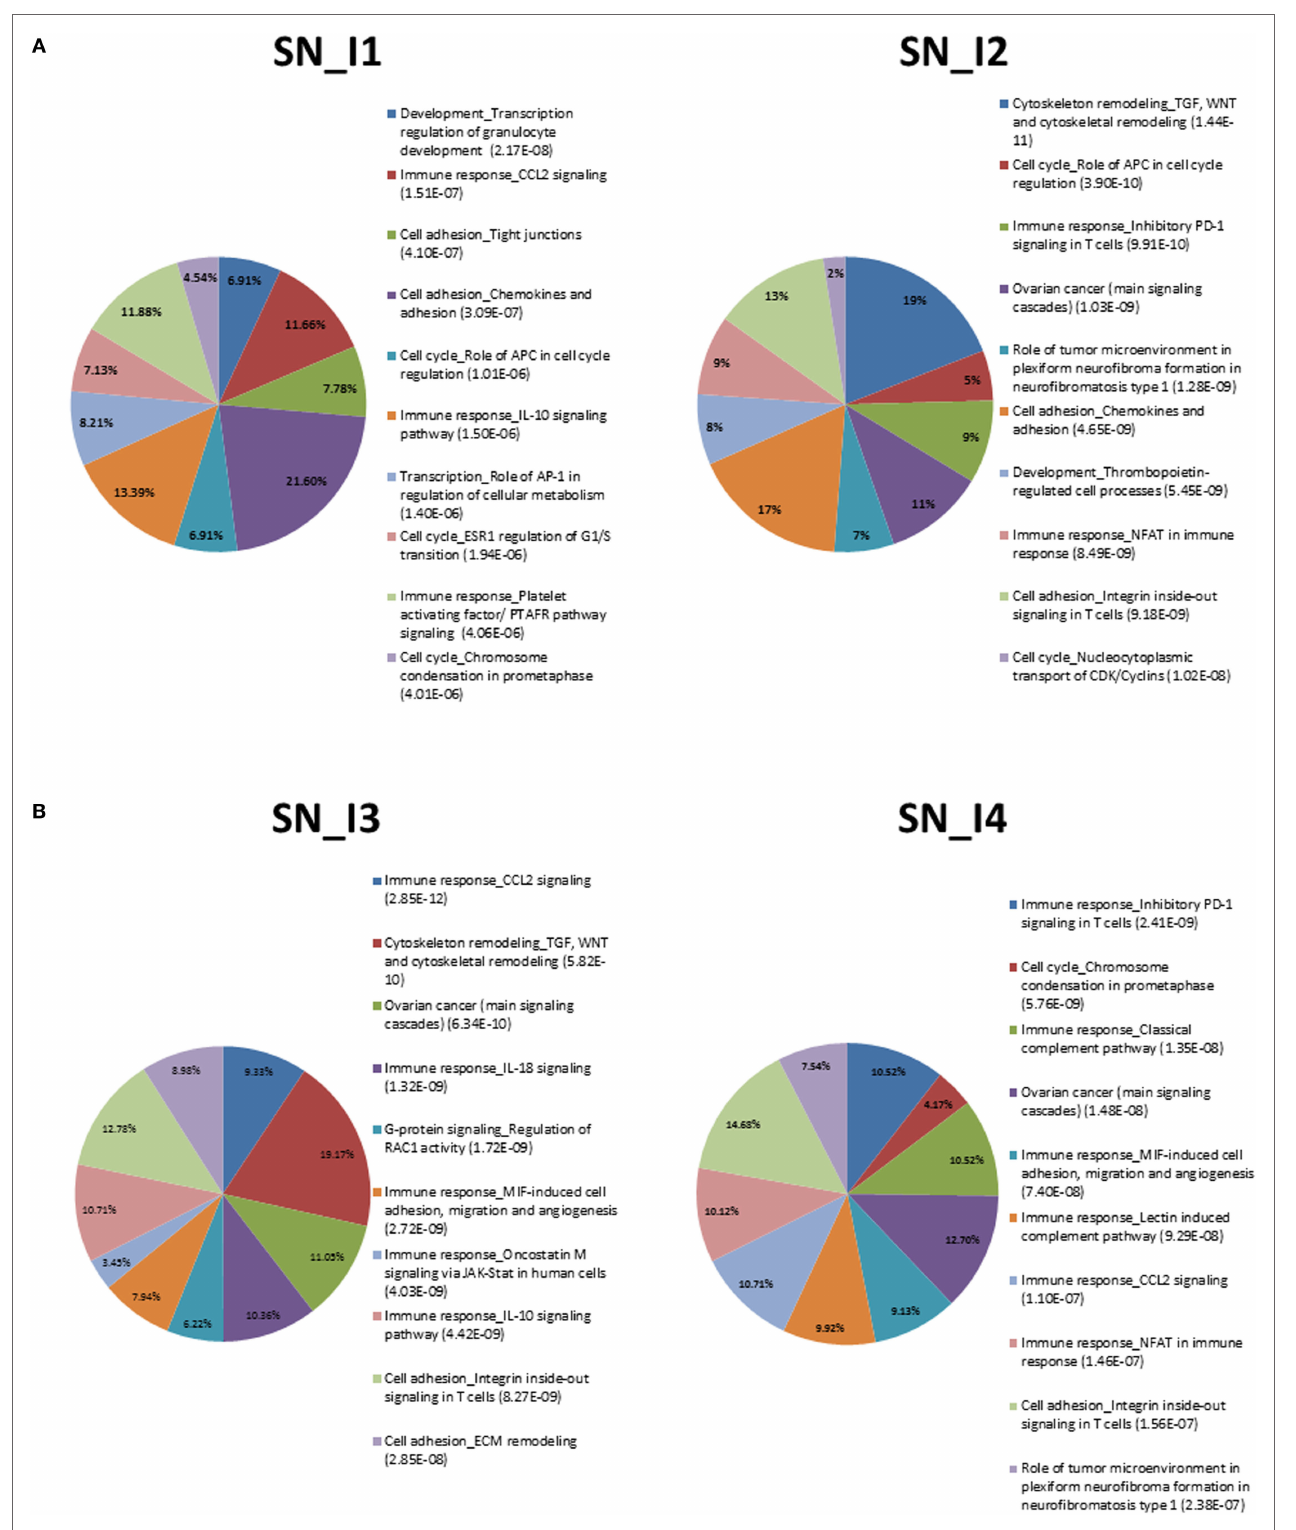
FigUre 1 | (a) Summary of top-10 pathways in SN_I1 (left) and SN_I2 (right). Percentage inside the pies represents enriched genes. FDR-corrected enrichment values are reported with listed pathway terms. (B) Summary of top-10 pathways in SN_I3 (left) and SN_I4 (right). Percentage inside the pies represents enriched genes. FDR-corrected enrichment values are reported with listed pathway